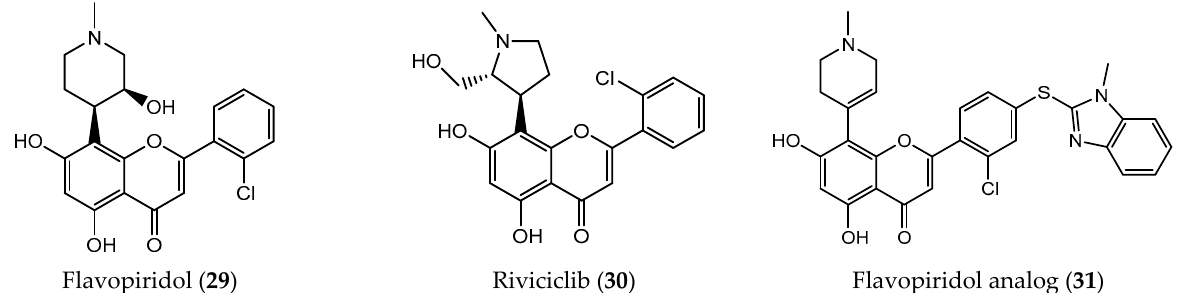
Figure 8. Chemical structure of flavopiridol ( 29 ) and its analogues ( 30 and 31 ). Chrysin (5,7-dihydroxyflavone) is a dietary phytochemical belonging to the flavone class widely found in honey and propolis which has been shown to have antiproliferative activity in several human tumor cell lines, such as colorectal [124], gastric [125], lung [126], melanoma [127] and prostatic [128]. Moreover, the antitumor activity of this flavone has been demonstrated in hepatocellular [129] and thyroid tumors in animal models [130].